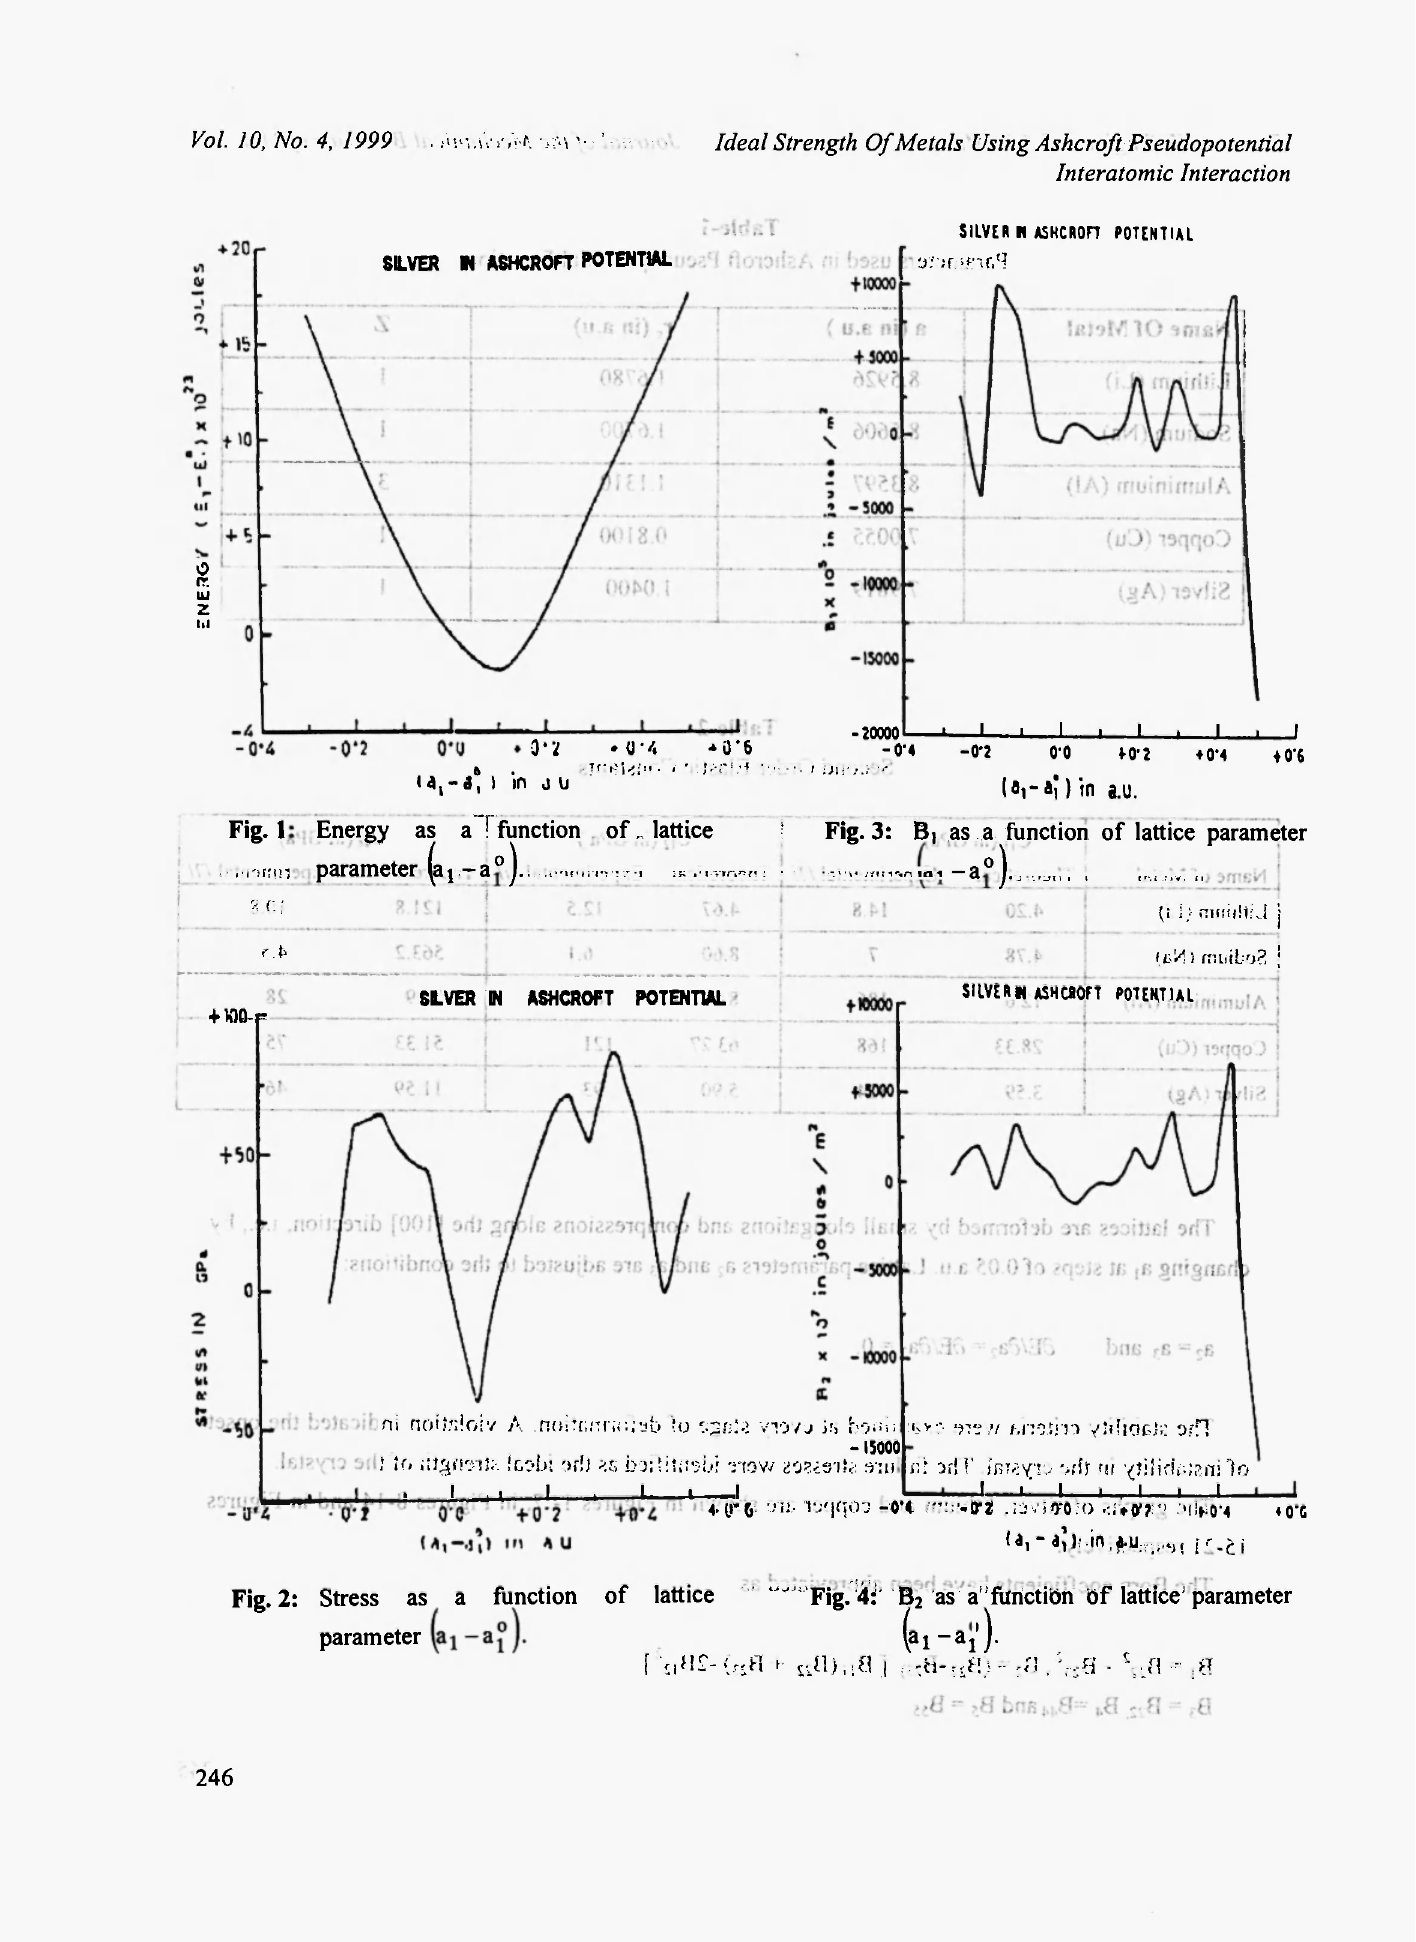
as a function of lattice Fig. 4i' B 2 as a filrictiön öf lattice' parameter